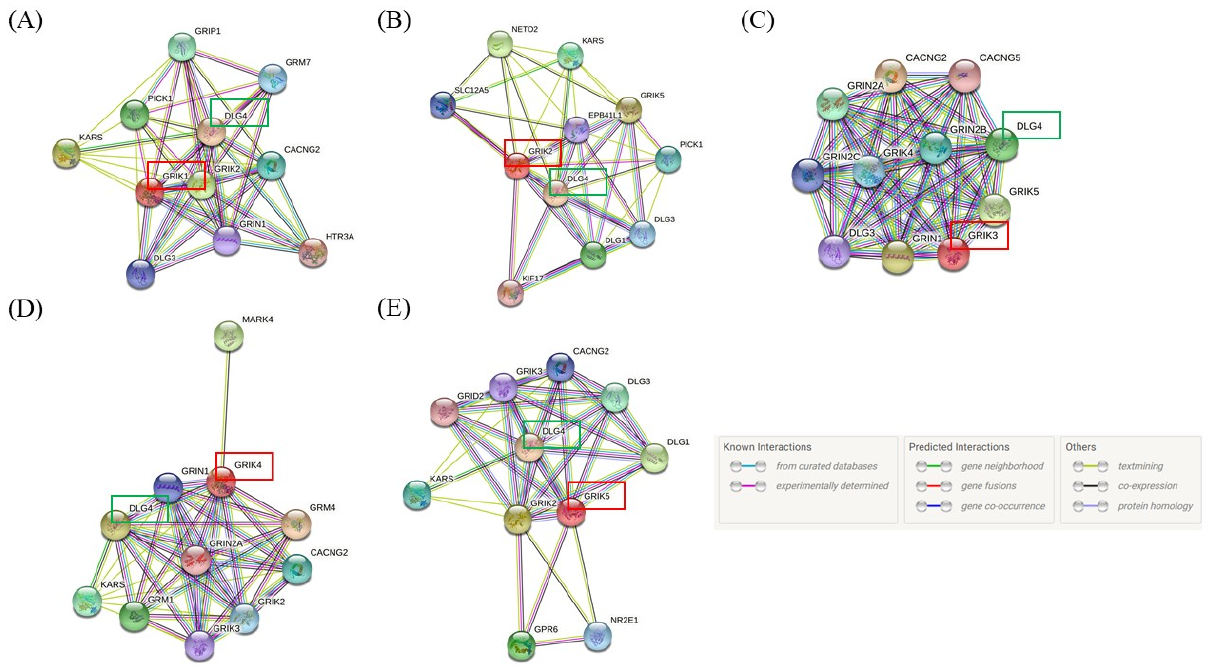
Figure 3. Graphical representation of the GRIK gene family network. ( A ) GRIK1 : number of nodes: